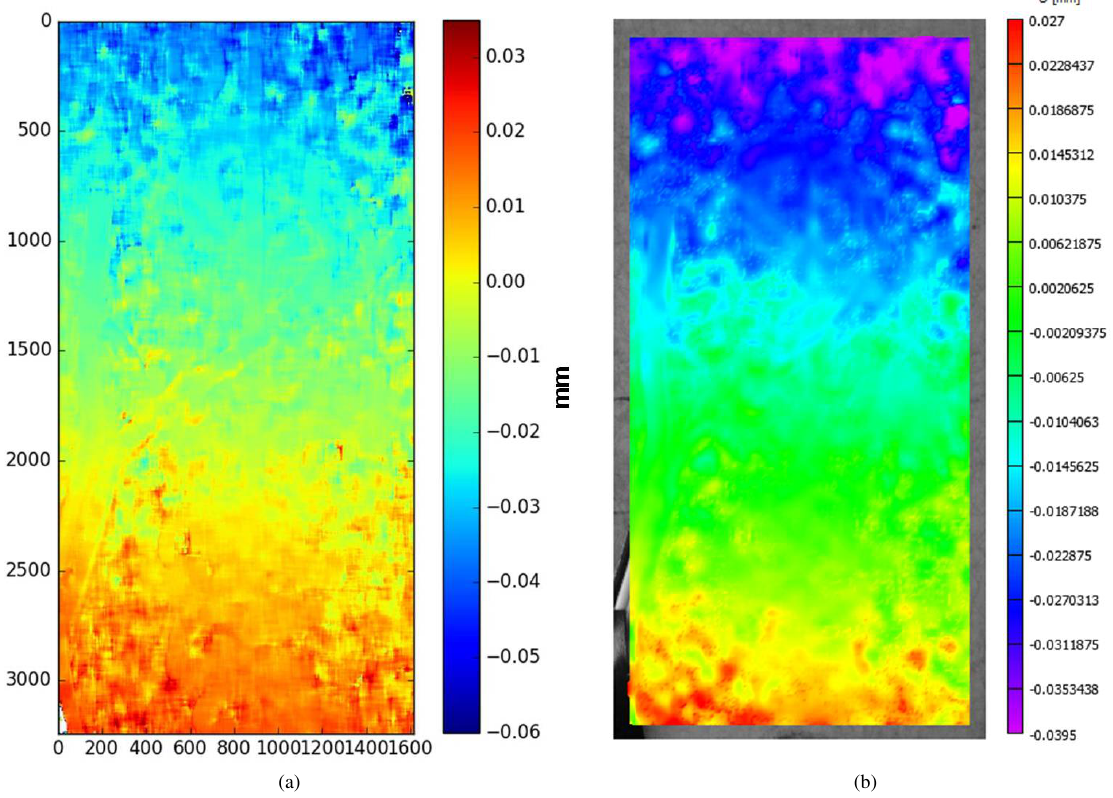
Figure 2: u displacement for the tensile test of GFRP sample obtained from DIC technique. (a) From py2DIC (b) From Vic-2D.